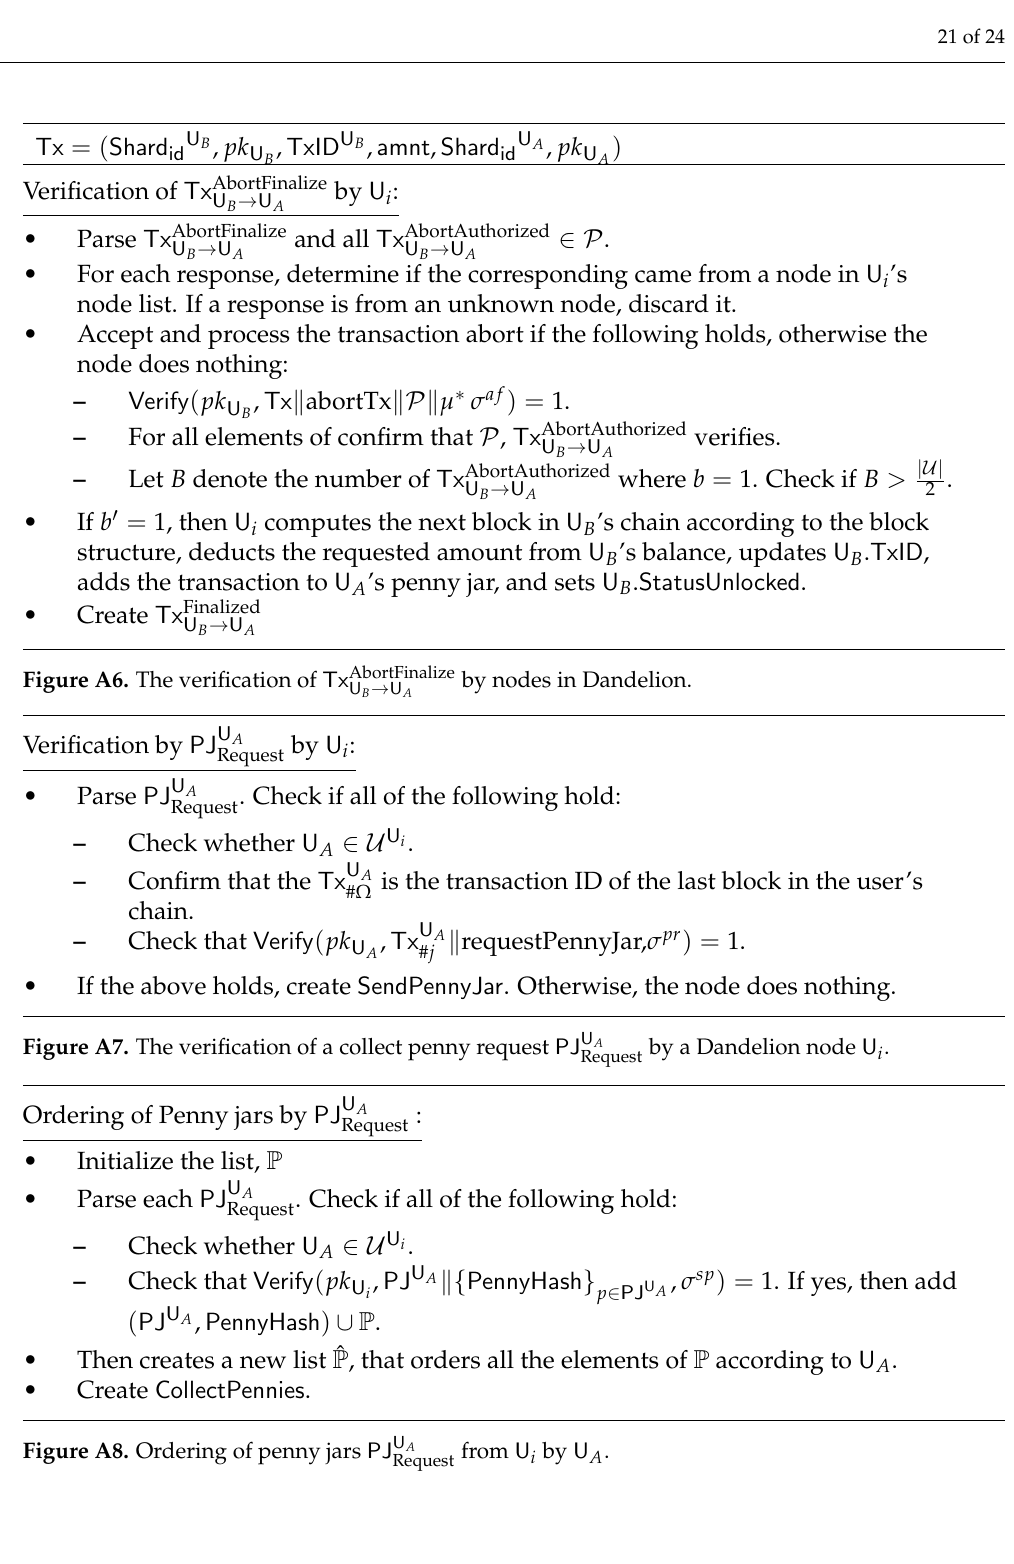
from U i by U A Request